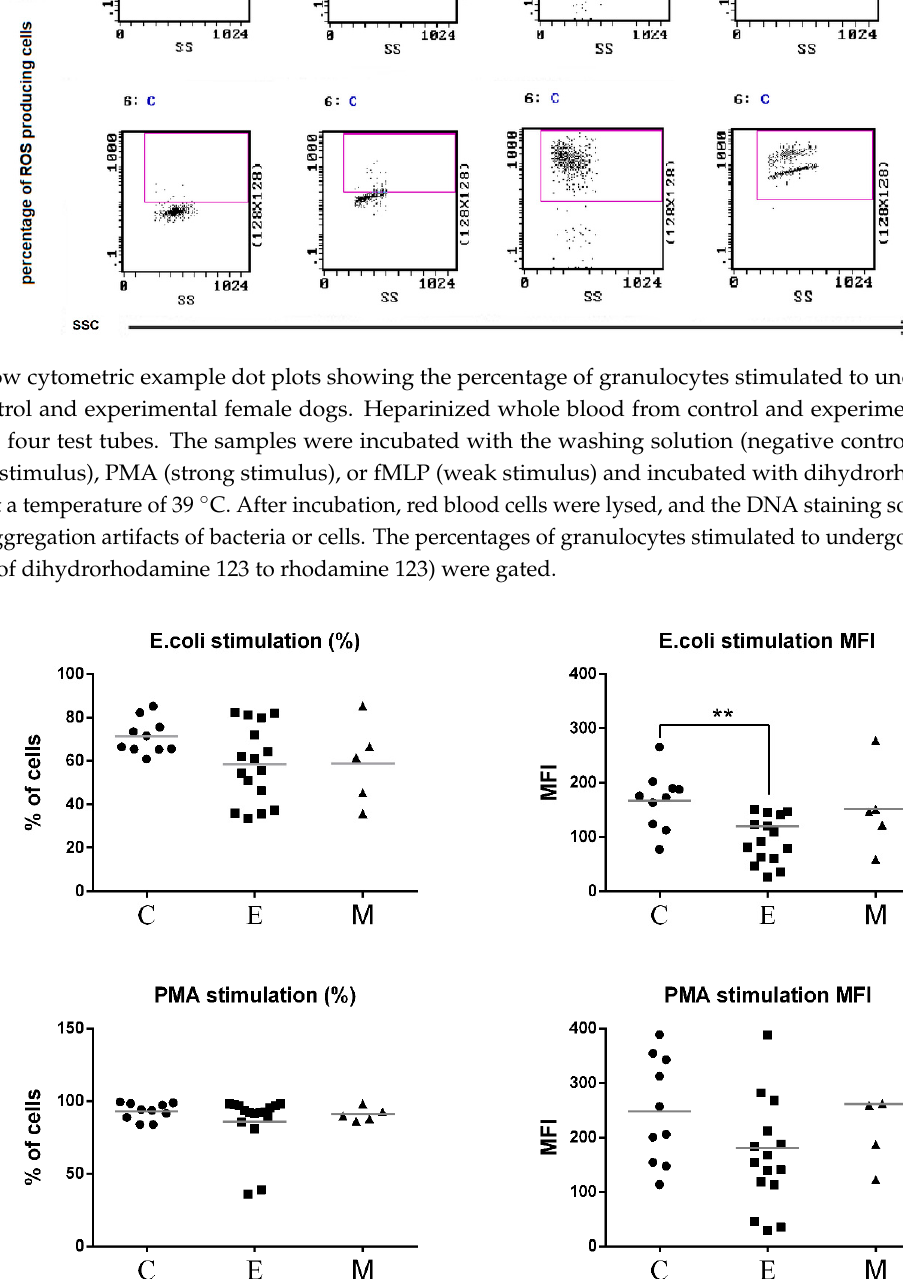
Figure 9. Flow cytometric results showing the mean values of the percentages and MFI of granulocytes producing reactive oxygen species (ROS) in the peripheral blood of female dogs with malignant tumors of diverse origin and the control group. Mean values of granulocyte percentages ( ± SD) in female dogs with tumors of epithelial origin (E); mesenchymal origin (M); and the control group (C). Statistically significant differences at p < 0.01 (**).